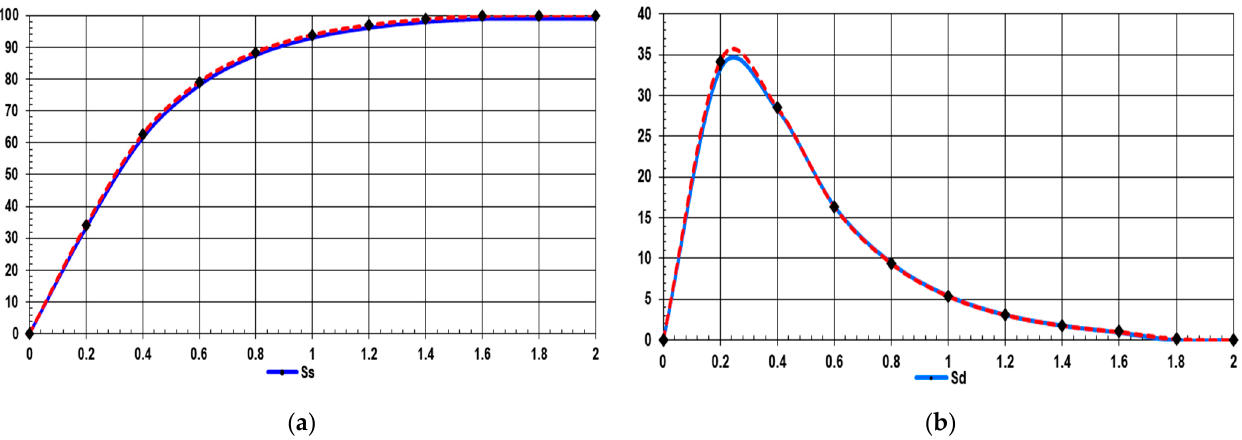
Figure 5. Variation in the distribution functions. ( a ) Function of separated seeds S s . ( b ) Function of the distribution density, S d , along the threshing apparatus length L (where: ♦ experimental points; curve drawn by points; theoretical curve drawn by points;